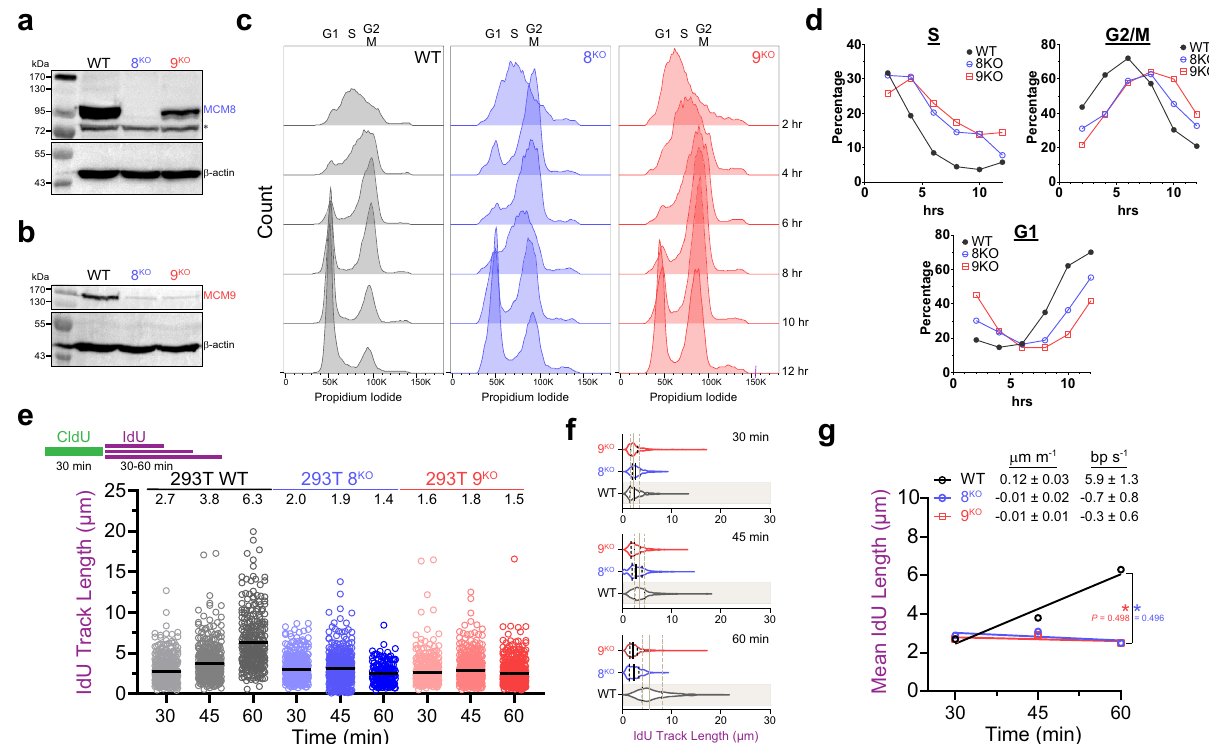
Fig.1|DNAreplicationratesarereducedintheabsenceofMCM8/9,leadingto delayed cellcycleprogression. Westernblots showing the absenceof a MCM8 or b MCM9 in their respective knockout cell lines ( n =2 independent blots). B-actin wasusedasaloadingcontrol.*indicatesthepresenceofanonspeci fi cband. c Cells were synchronizedwith a double thymidine block,releasedinto S-phase, and then thechromosomecontentwasmonitoredbyFACS. d Aftergatingandquanti fi cation ofS,G2/M,andG1populations,thepercentageswereplottedasafunctionoftime. e Dual labeling DNA fi ber assay with a constant 30min CldU pulse followed by a variable 30 – 60min IdU pulse. The IdU track lengths adjacent to a constant CldU